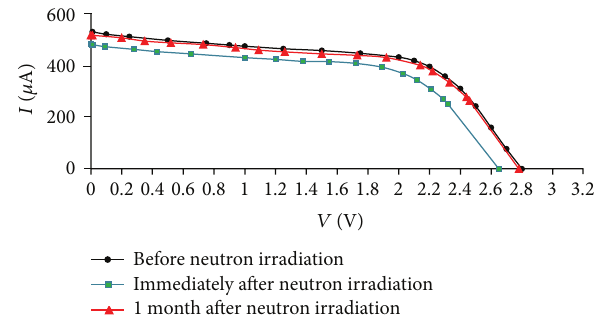
Figure 1: 𝐼 - 𝑉 characteristics of the solar panels before and after neutron